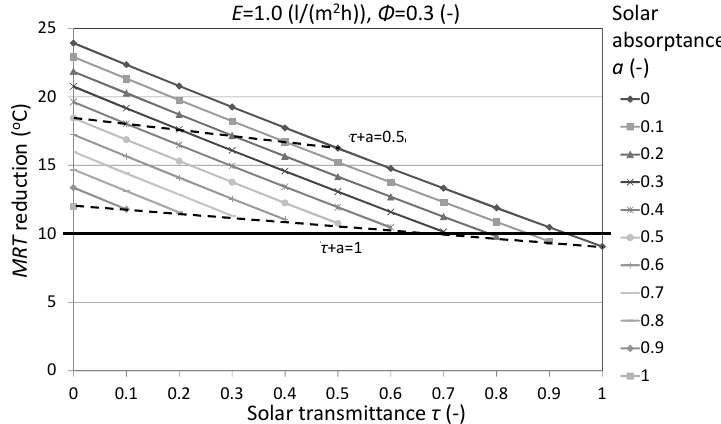
the solar absorptance a . absorptance a .